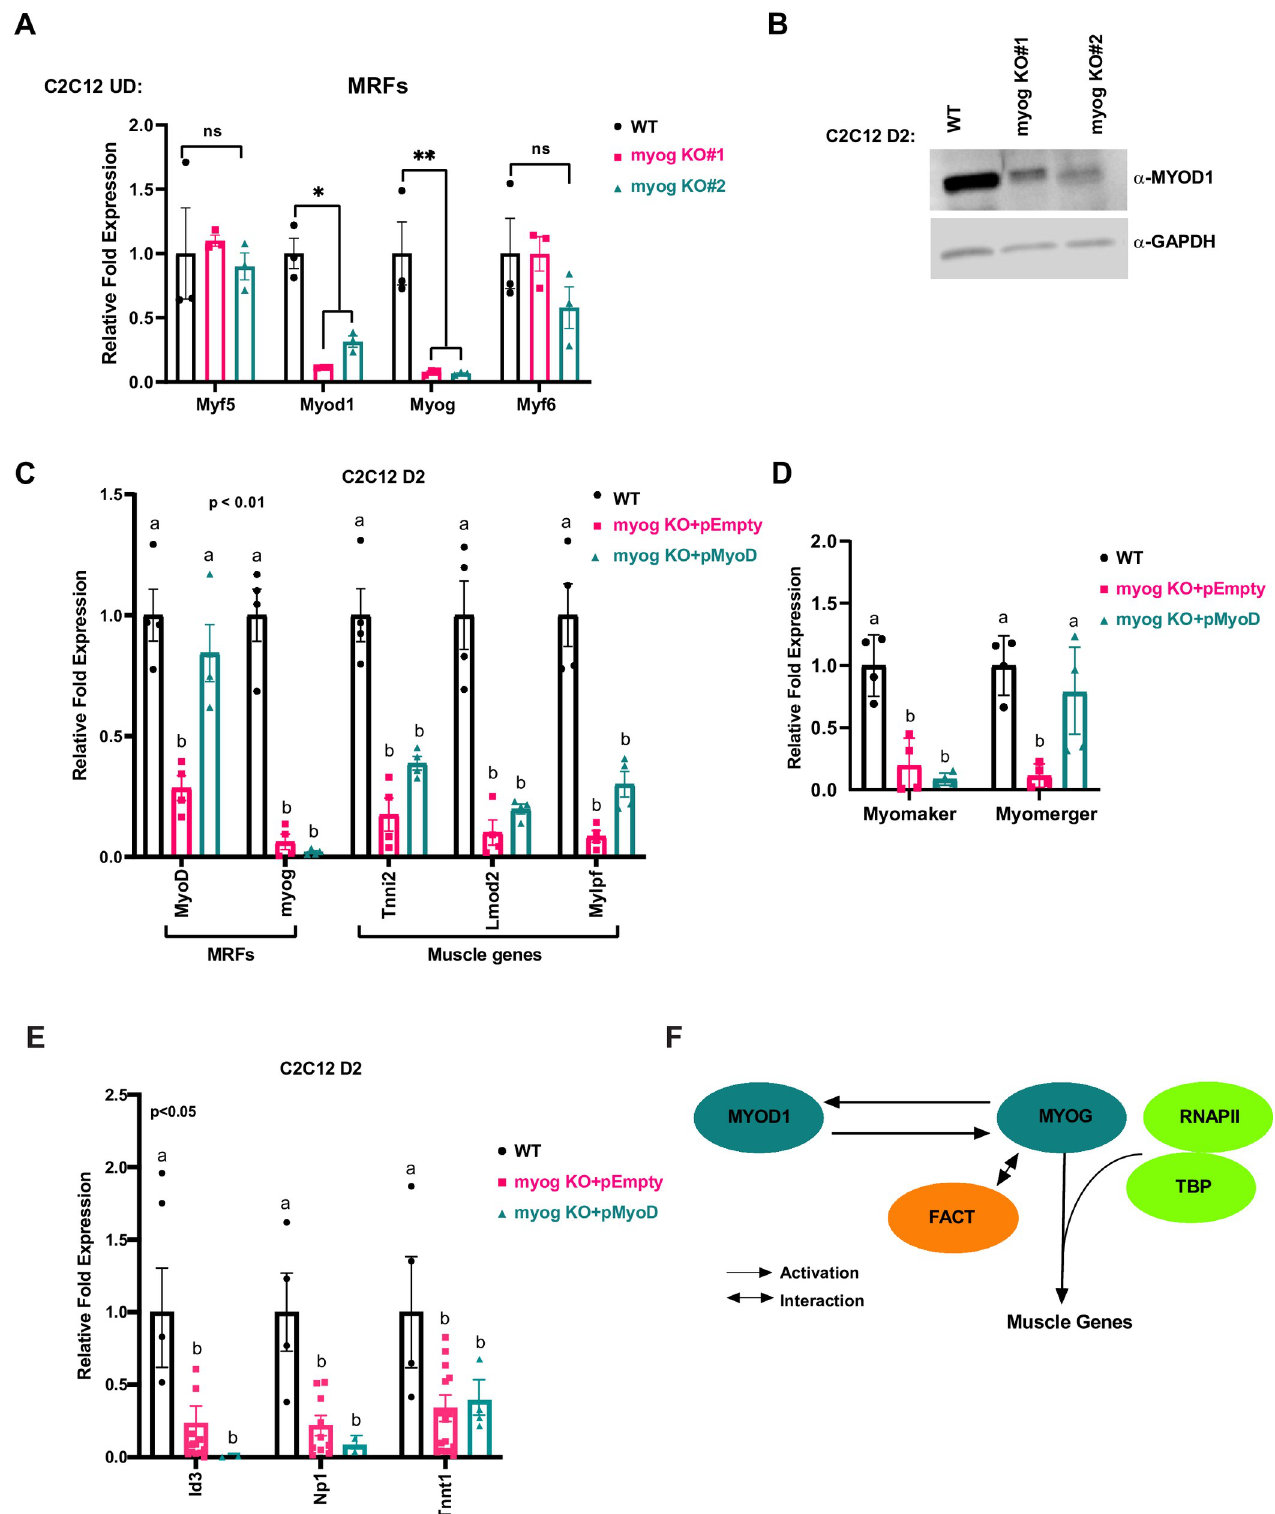
Fig 6. MYOG regulates MYOD1 in C2C12 cells and is required for muscle gene activation. A. C2C12 clones with the Myog deletion were grown in proliferating condition (U.D.) and were harvested for total RNA and assayed for the expression of Myf5 , Myod1 , Myog , and Myf6 by qRT-PCR. Standard errors